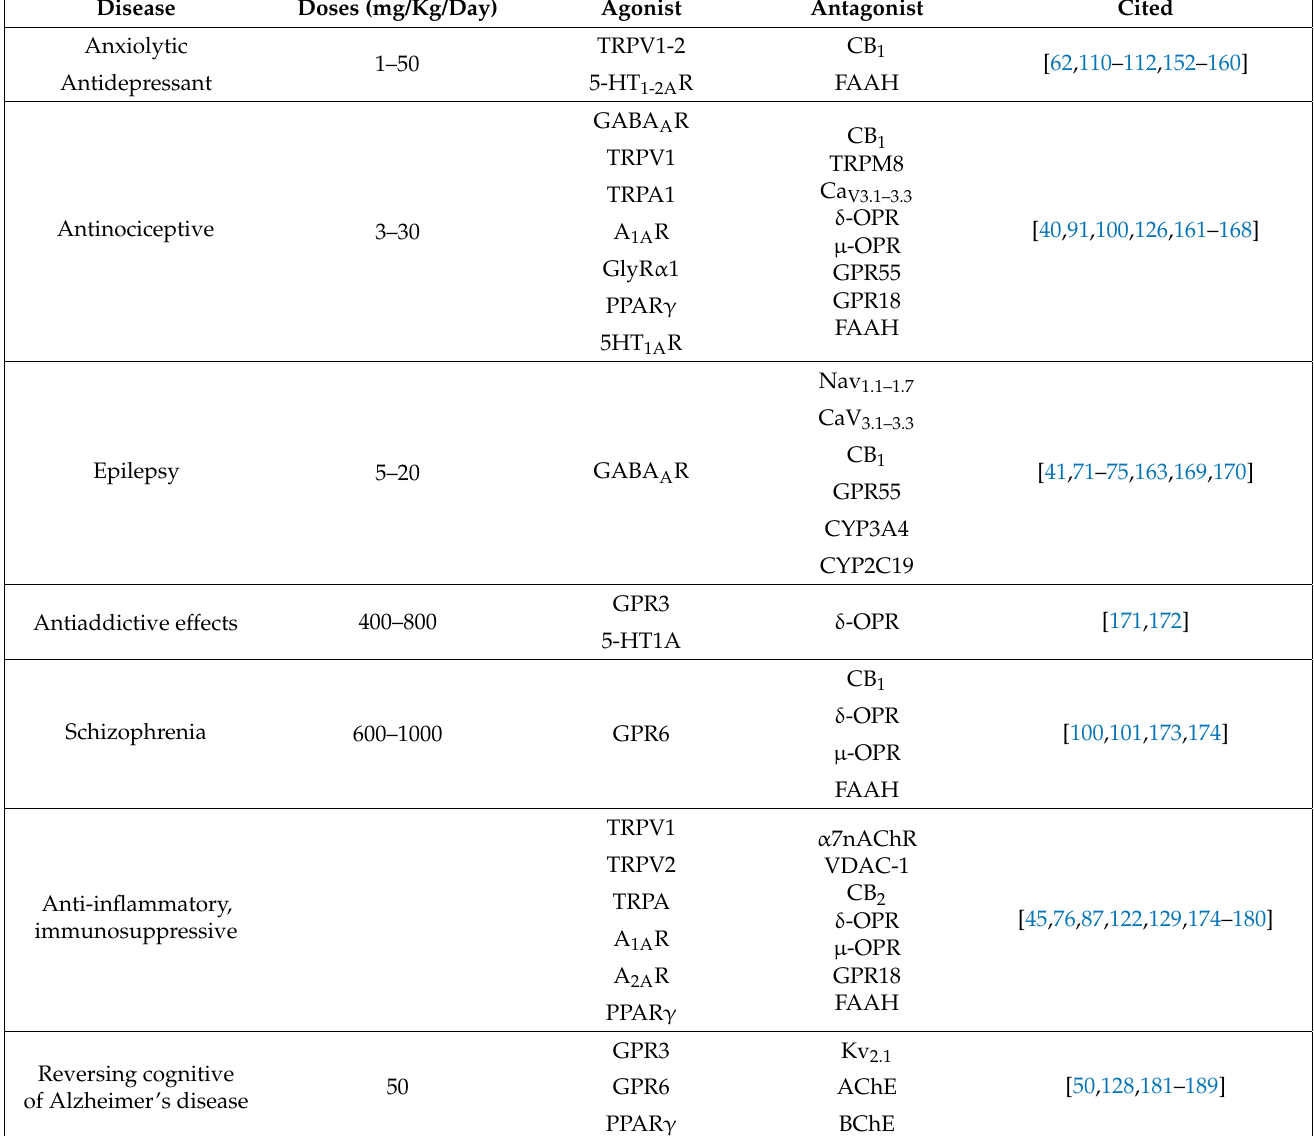
Table 5. Targets of CBD on neurological